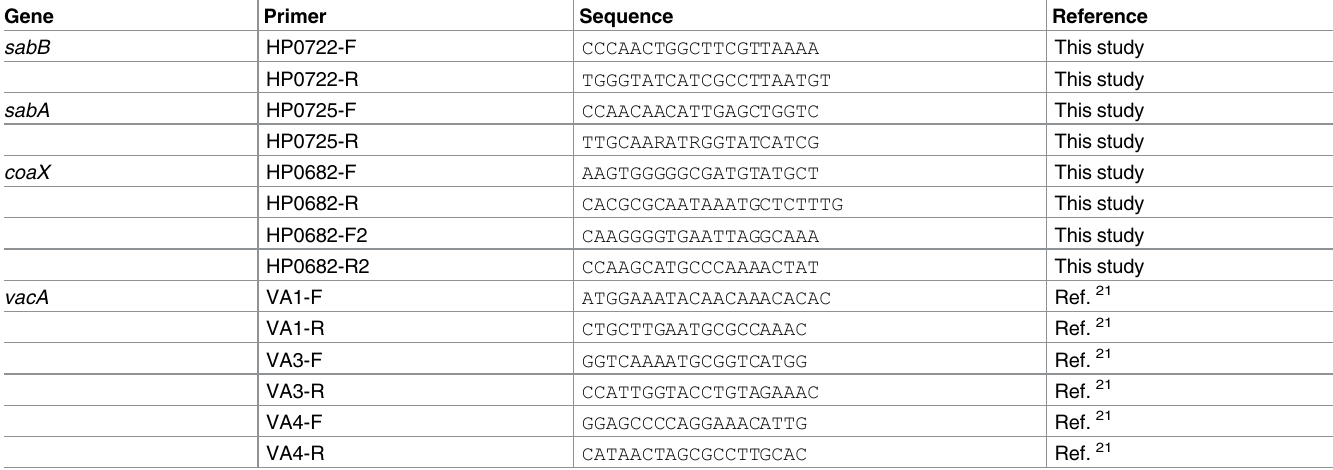
Table 1. Primers used for PCR in this study.